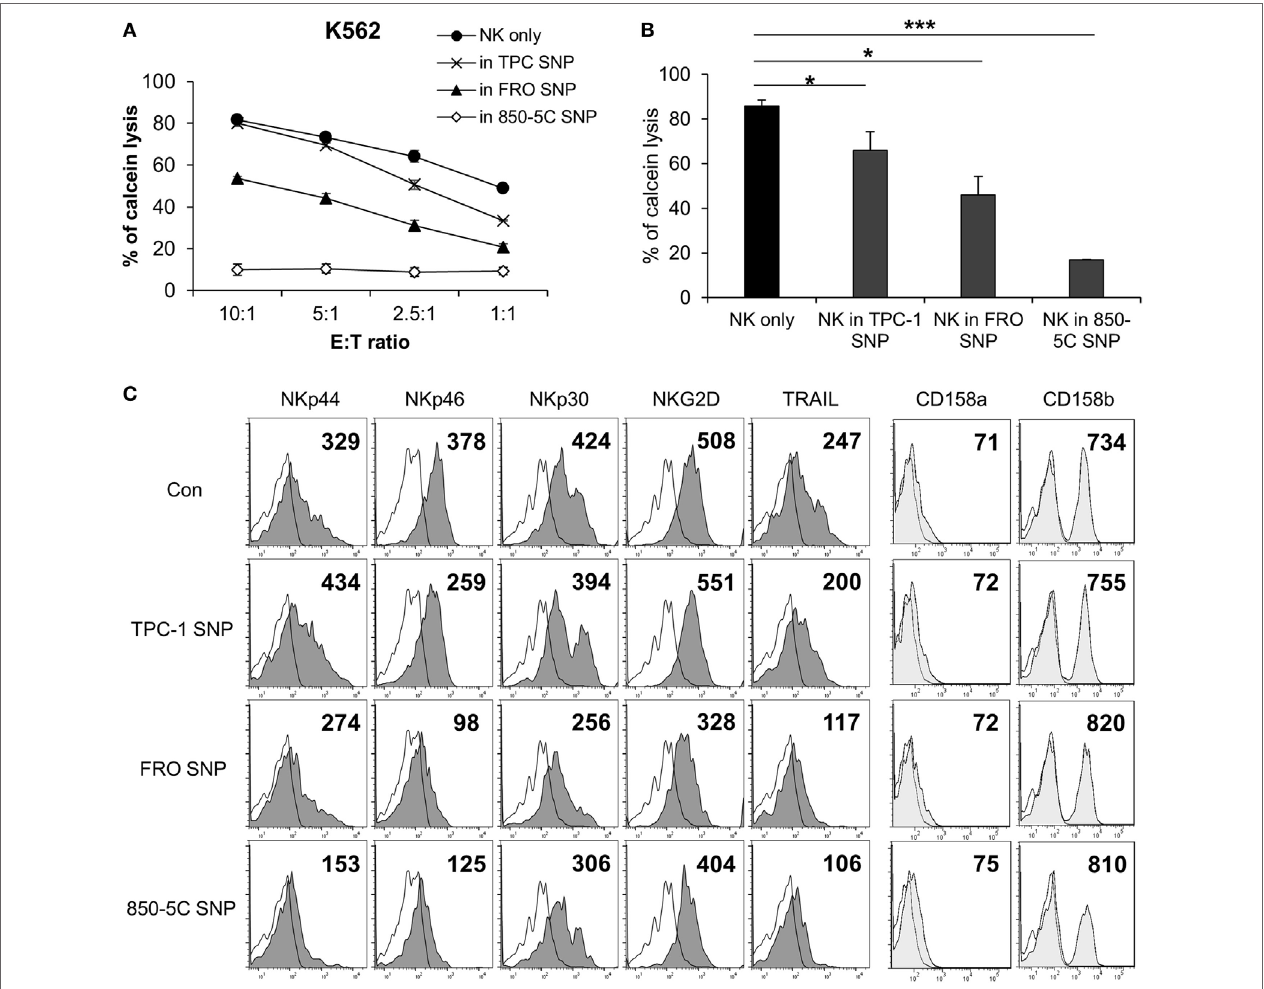
FigUre 1 | Culture supernatants of thyroid cancer cells inhibit natural killer (NK) cell cytotoxicity. (a) NK cells were cultured with IL-2 either in control medium (circle) or in medium containing culture supernatant of thyroid cancer cells including TPC-1 (cross), FRO (triangle), and 850-5C (diamond) for 48 h. The cytotoxicity of the NK cells was assessed relative to K562 cells at different E:T ratio as described in Section “Materials and Methods.” Bars represent mean ± SD from three experiments. (B) Percent cytotoxicity by NK cells treated with culture supernatants of thyroid cancer cells relative to NK cells grown in control medium. K562 cells were used as targets and the effector:target (E:T) ratio was bar which represent mean ± SD of three independent experiments. Statistical analysis was performed using the paired two-tailed Student’s t -test. * P < 0.05 and *** P < 0.001. (c) Expression of NK activating receptors and death receptors (profiles filled with dark gray), inhibitory receptors (profiles filled with light gray), and isotype controls (white profiles) was analyzed by flow cytometry. Numbers indicate mean fluorescence intensity. Y -axis shows cell